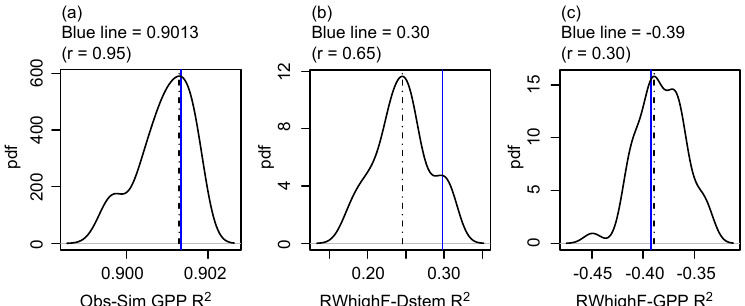
Figure 2. Variance explained by the model. (a) R 2 between observed and simulated GPP daily values. R 2 (computed on data transformed to z scores) between the mean of the detrended series of black spruce ring growth (RWhighF) and simulated yearly detrended C allocation to the stem (b) or GPP (c) . Vertical dashed line is the mode, and the blue line is the value with plausible block GPP (in a ) or with plausible block stem (in b, c ). All probability density functions are based on 50